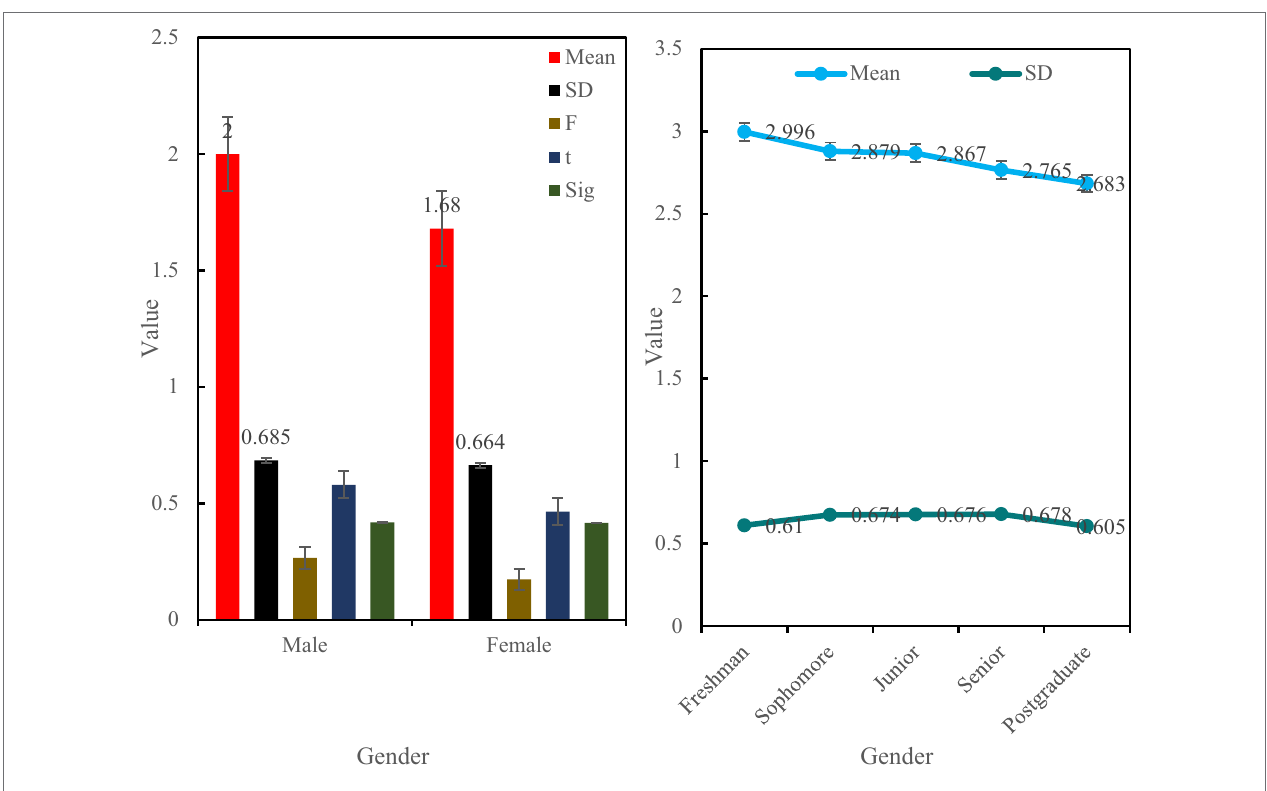
FIGURE 11 | Comparison of the differences in student satisfaction of university teaching psychology management in gender and